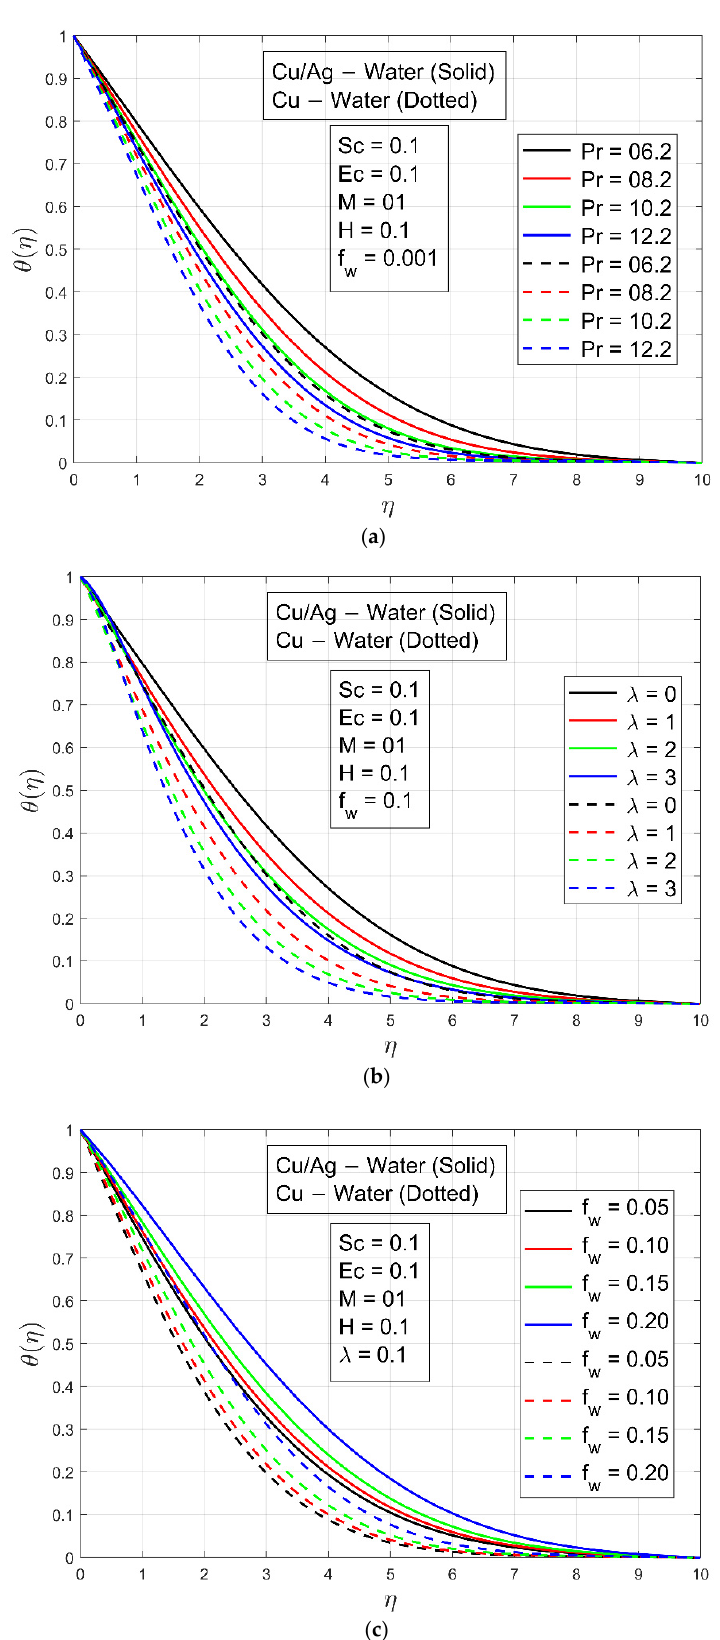
Figure 5. ( a ) Temperature profile θ ( η ) for different values of Pr . ( b ) Temperature profile θ ( η ) for different values of λ . ( c ) Temperature profile θ ( η ) for different values of f w